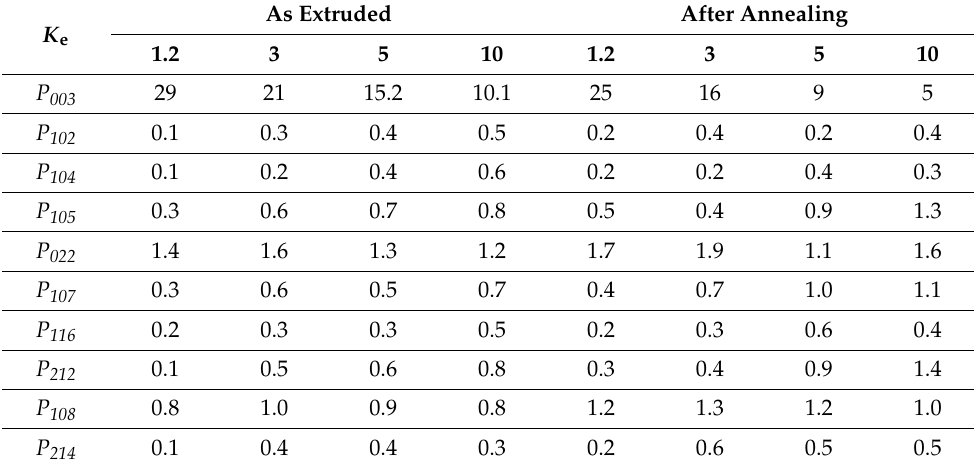
Table 2. Pole density P hkl of the normals to reflecting planes (hkl) in the direction of the extrusion axis for Bi 0.91 Sb 0.09 crystals, before and after annealing at 180 ◦ C for 8 h.